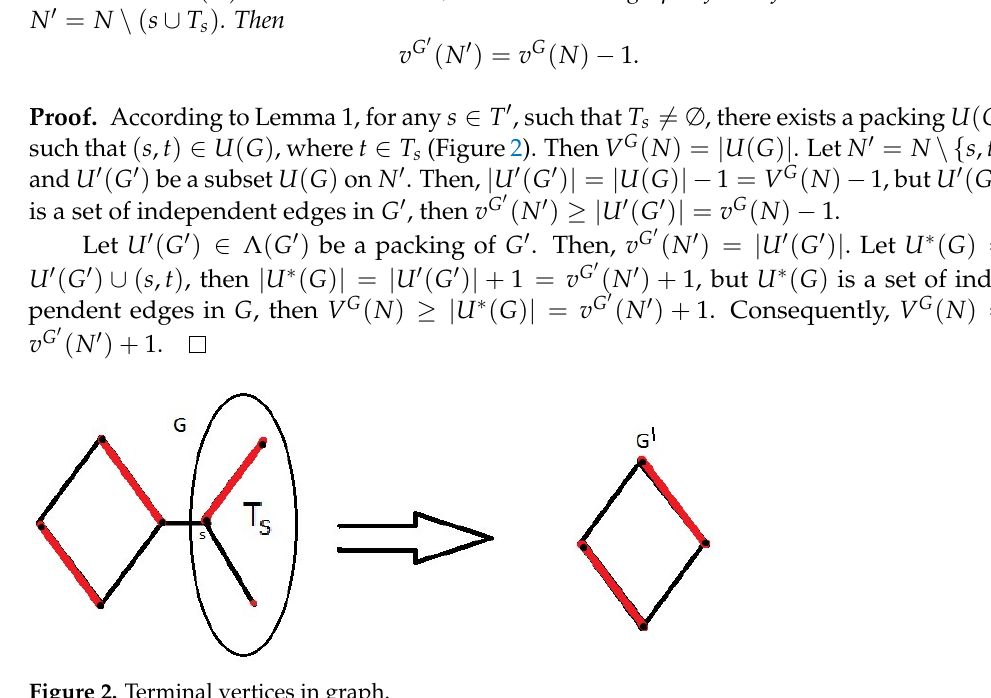
Figure 2. Terminal vertices in